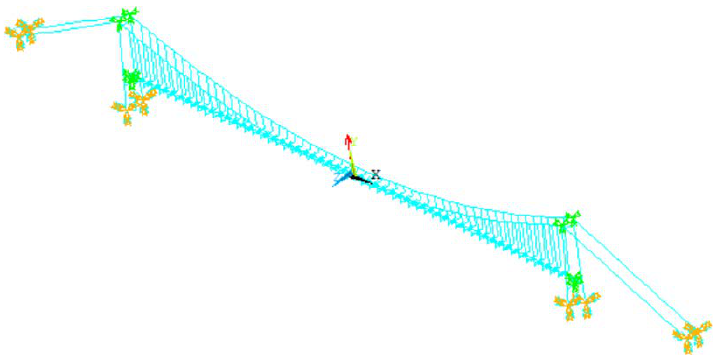
Figure 3. Bridge finite element model diagram.